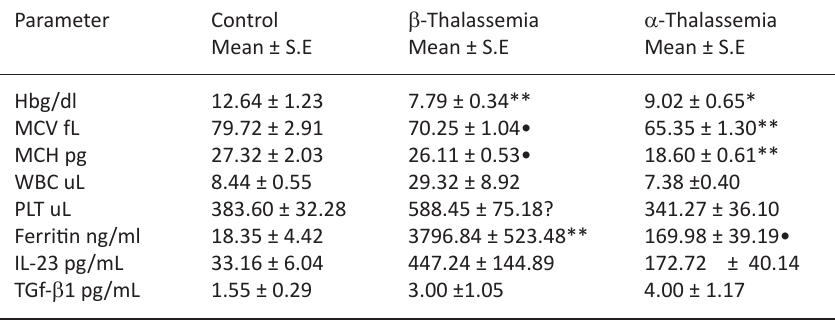
Table 1. Hematological and Immunological parameters in patients with